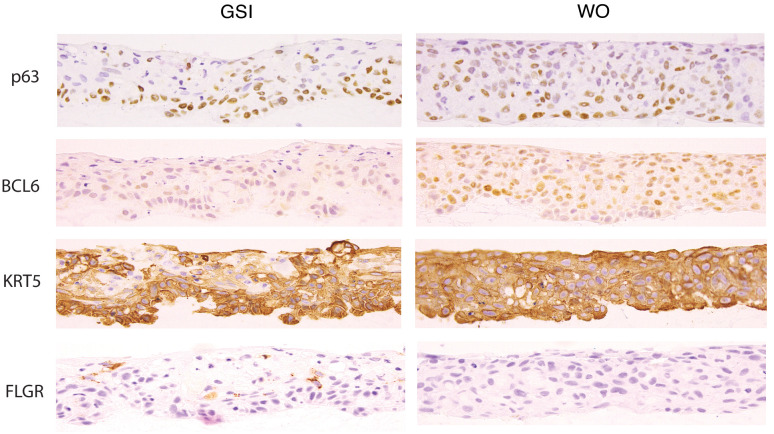
Immunohistochemical assessment of p63, BCL6, keratin5 (KRT5), and filaggrin (FLGR) protein levels in S2 cells grown in the Notch-off (GSI) or Notch-on (WO) states in 3D rafts.